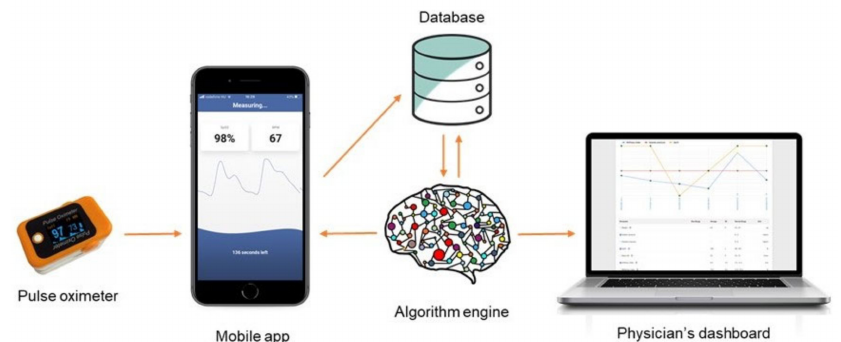
Figure 2. Outline of the SCN4ALL telemedicine system. Peripheral arterial pulse wave is detected by a transmission pulse oximeter. The device (Berry Pulse Oximeter, Shanghai Berry Electronic Tech Co., Ltd., Shanghai, China) communicates via Bluetooth connection with a mobile application (SCN4ALL) which initiates and terminates the 2-min-long data acquisition and transmits the recording to a cloud database. A cloud-based automated algorithm calculates the pulse contour variables which are then reported to the dashboard of the physician and, in brief form, to the mobile application of the